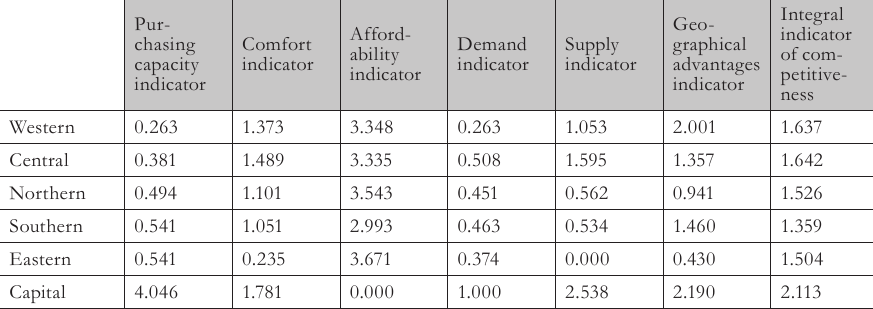
Tab. 9 – Integral competitiveness components of Ukraine RREM. Source: own